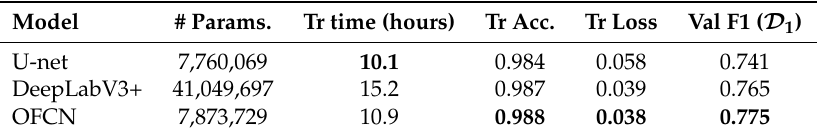
Table 5. Comparison with baselines. Reported is the number of trainable parameters, training time for 400 epochs, training accuracy, training loss, and F1 score on the validation. Best results are in bold. Models are trained on an Nvidia RTX 2080.